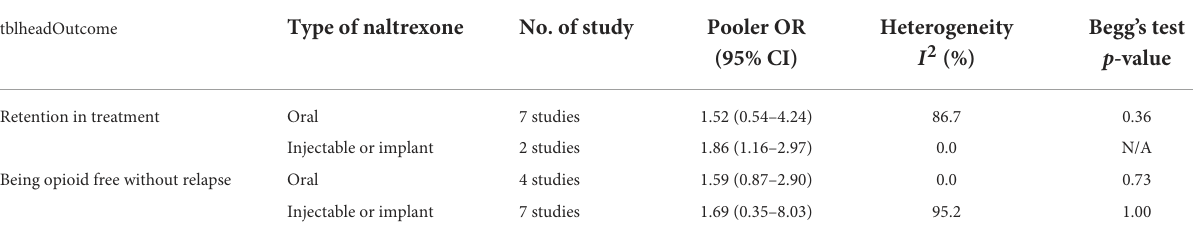
TABLE 4 Subgroup analysis for naltrexone